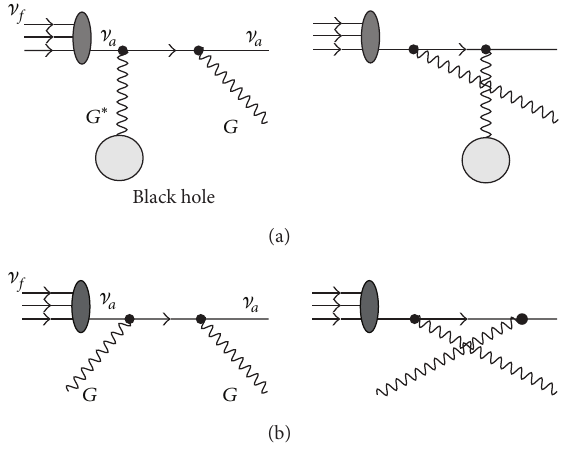
Figure 1: The quasi-classical gravity processes which destroy the coherence of the neutrino flavor eigenstate ( 𝑓 = 𝑒, 𝜇,𝜏 ) at the quantum level effectively turning it to a mass eigenstate ( 𝑎 = 1 , 2 , 3), the gravitational Bethe-Heitler-type scattering of neutrino off a massive object, for example, a black hole (a) and the gravitational Compton scattering (b). The dark ellipse is a projection to a fixed mass state and the shaded circle is a classical source of the gravitational field.